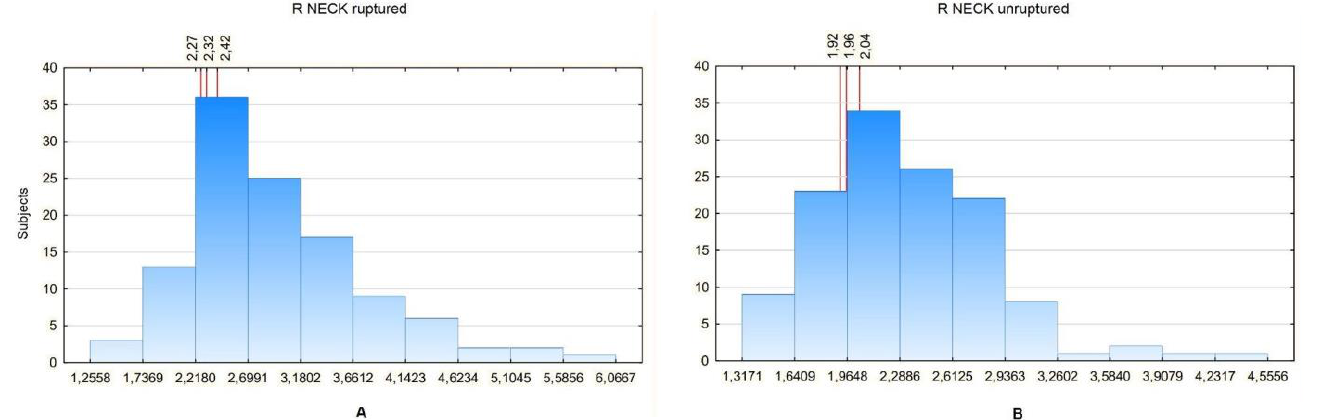
Figure 8. ( A ) R NECK values distribution in a certain number of patients with ruptured aneurysm. For the 20th percentile: 2.27, 25th percentile: 2.32, 30th percentile: 2.42. ( B ) R NECK values distribution in a certain number of patients with unruptured aneurysm. For the 20th percentile: 1.92, 25th percentile: 1.96, 30th percentile: 2.04.